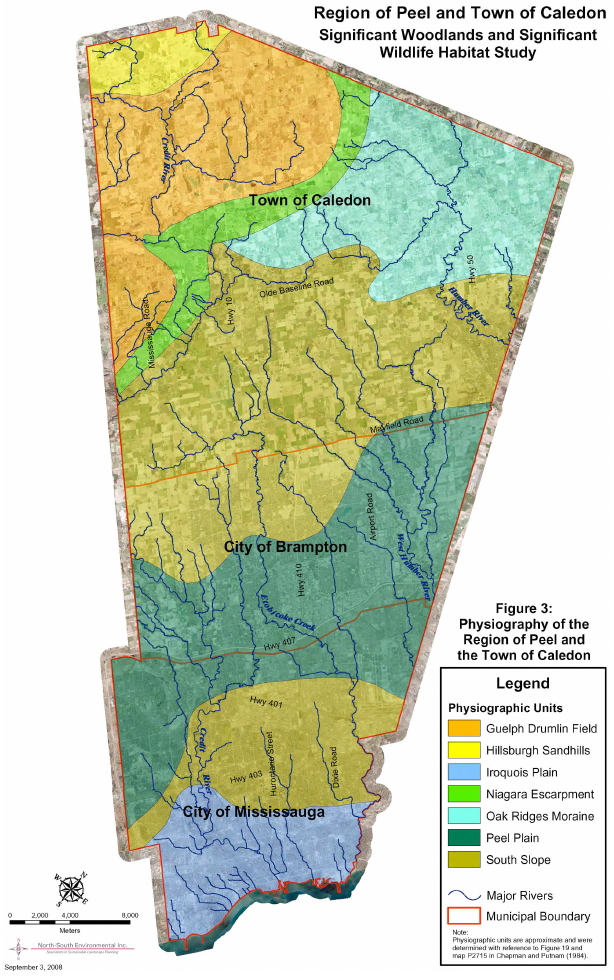
Environmental Inc. et al., unpublished manuscript, Fig. 3.)